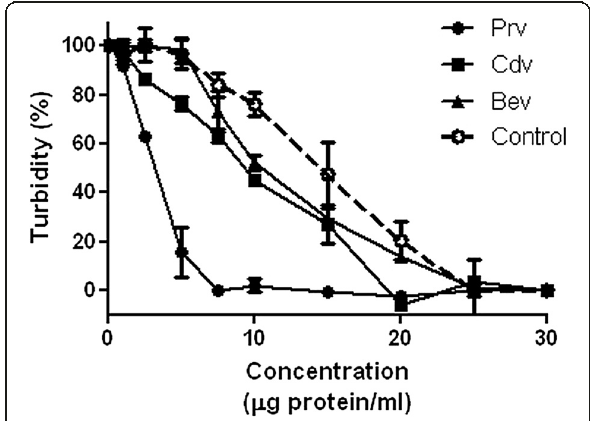
Fig. 4 Comparison of hyaluronidase activity displayed in P. regalis ( Prv ), C. darlingi ( Cdv ), and B. epicureanum ( Bev ) venoms. Hyaluronidase from bovine testes type IV-S was used as a positive control. Values represent the mean±standard error ( n